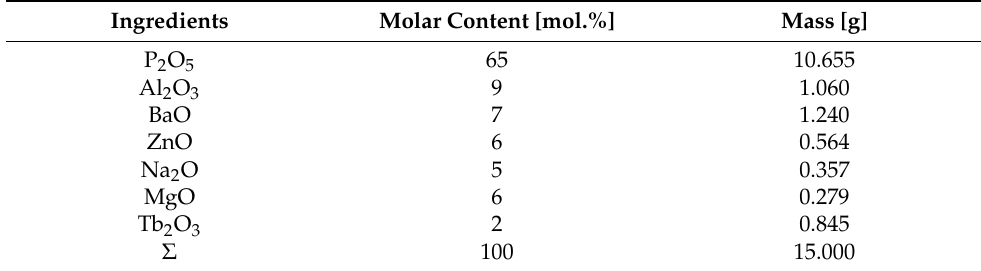
Table 2. Compositions of phosphate glasses doped with terbium ions (2% Tb 3+ ).